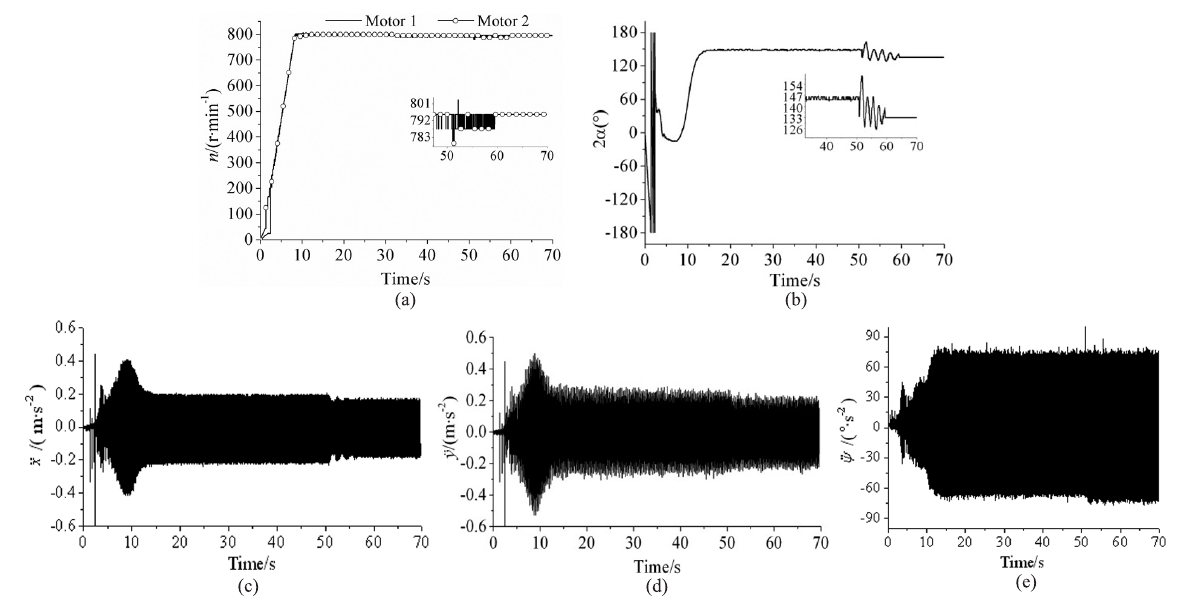
Fig. 8. The experimental results of the two non-identical exciters rotating in the same directions ( η = 0 . 5) : (a) Rotational velocities of the two exciters; (b) The phase difference between the two exciters ( 2 α = ϕ 1 − ϕ 2 ) ; (c) Acceleration in x -direction; (d) Acceleration in y -direction; (e) Acceleration in ψ